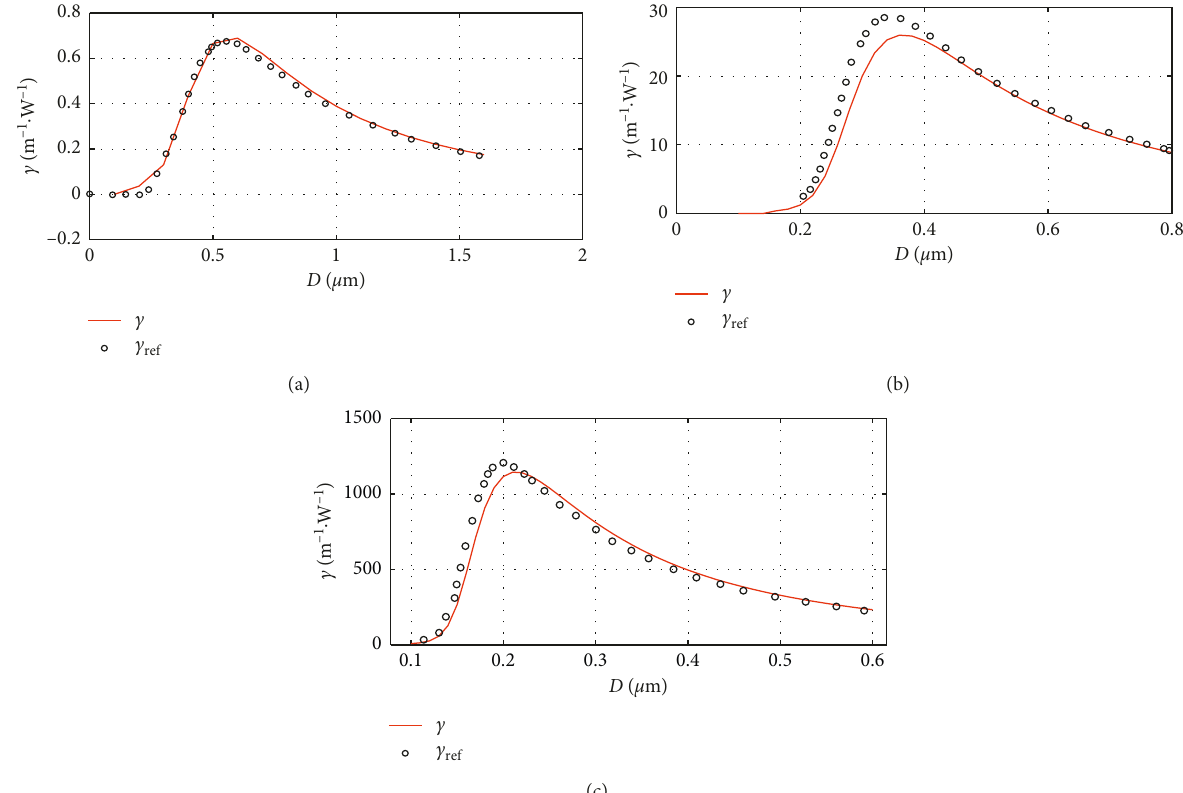
� 1 . 45, n � 1 . 0, n � 2 . 6 × 10 − 20 m 2 / W. (b) Bismuth rod: n c cl 2